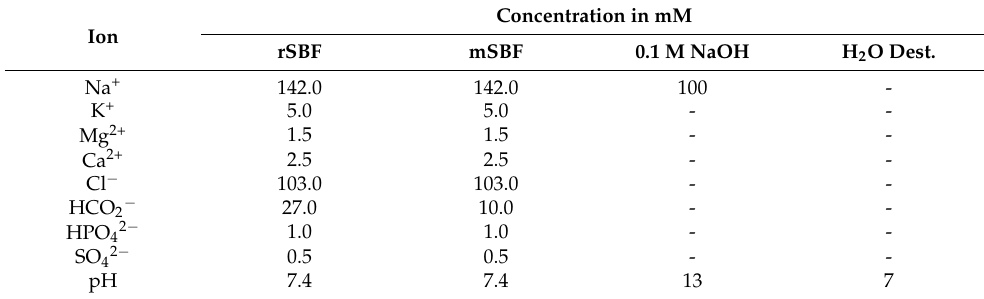
Table 1. Composition of the fluids used for the magnesium corrosion and polymer degradation experiments.